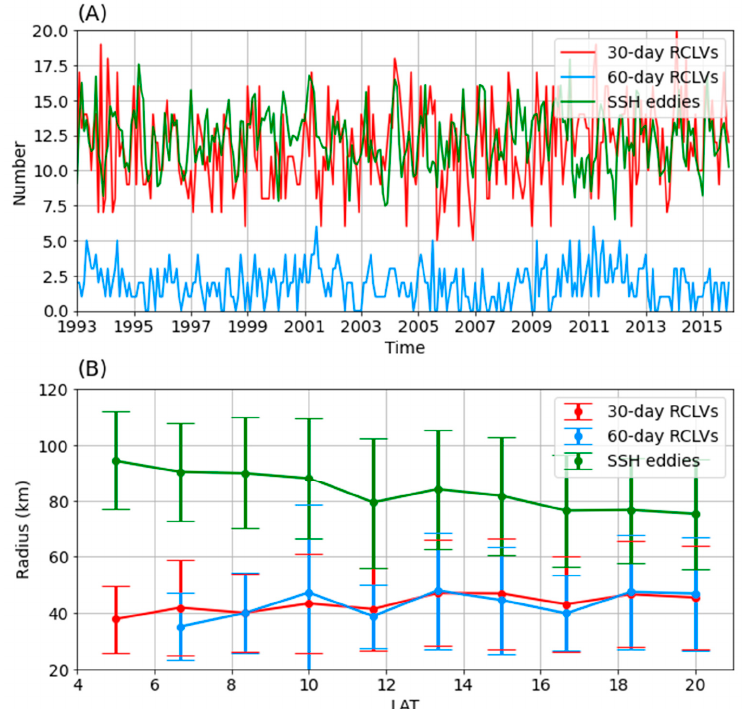
Figure 11. ( A ) Numbers of 30-day (red line) and 60-day (blue line) RCLVs per month from 1993 to 2015, with the total snapshot number of SSH eddies per month (divided by 30) as shown by the green line. ( B ) The radii of RCLVs and SSH eddies as a function of latitude. The error bar represents one standard deviation of the mean over all samples in a 1.5° bin.